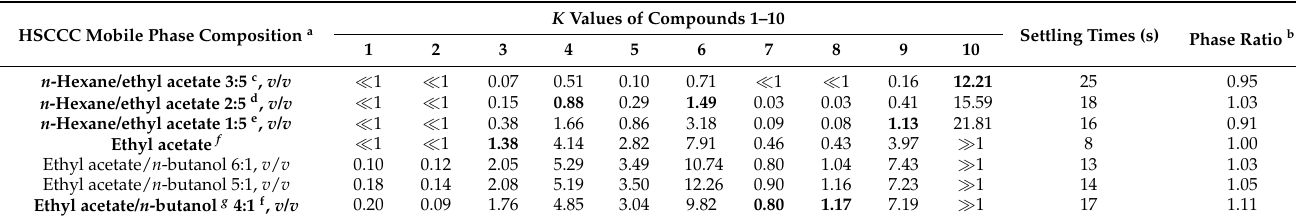
Settling Times (s) Phase Ratio b